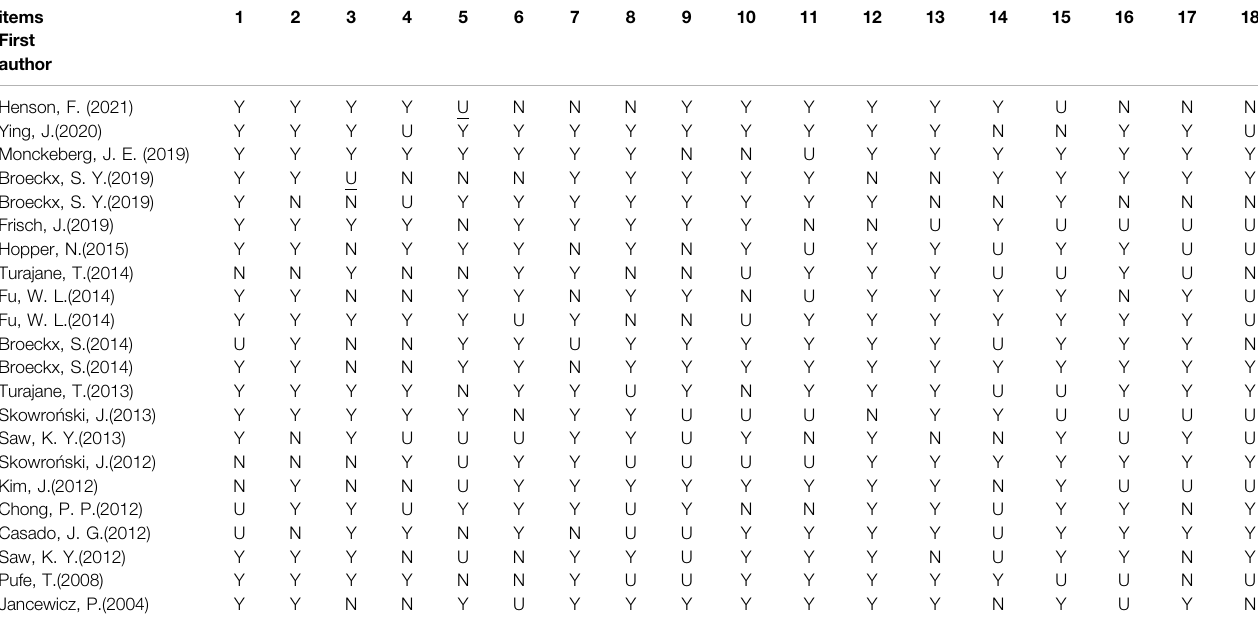
TABLE 4 | QUADAS quality assessment of other study(Y =Yes, N=No, and U=Unclear) based on the items that are described in the method